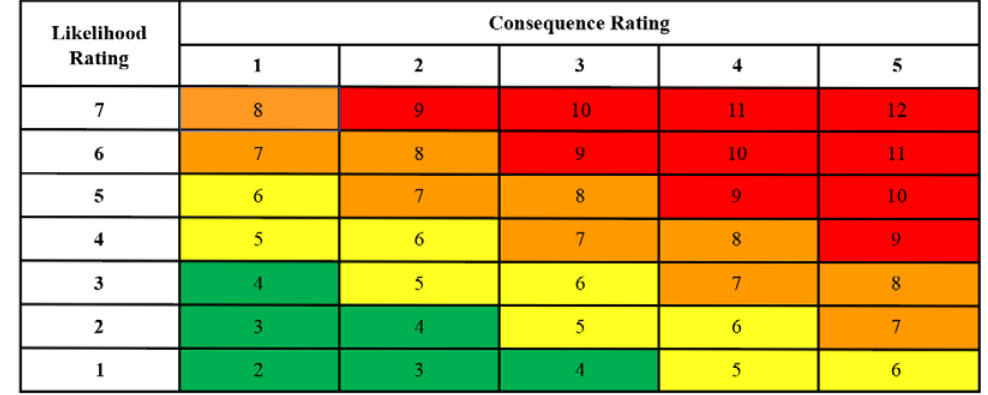
Figure A4. Colour-coded risk matrix based on addition of ordinal pairs. 6.